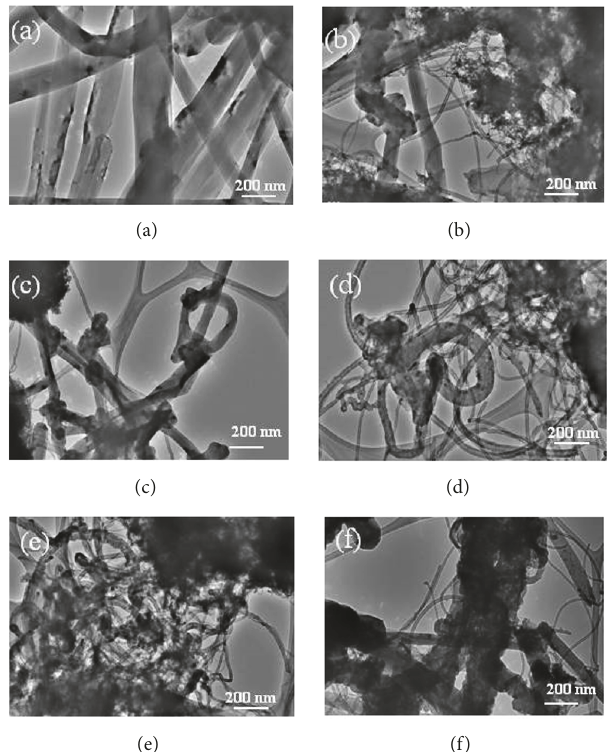
Figure 3: TEM images of the functionalized CNTs and CNTs-PMo- 𝑥 series of catalysts. (a) Functionalized CNTs; (b) CNTs-FePMo-150; (c) CNTs-FePMo-200; (d) CNTs-FePMo-250; (e) CNTs-FePMo-300; (f) CNTs-FePMo-350.